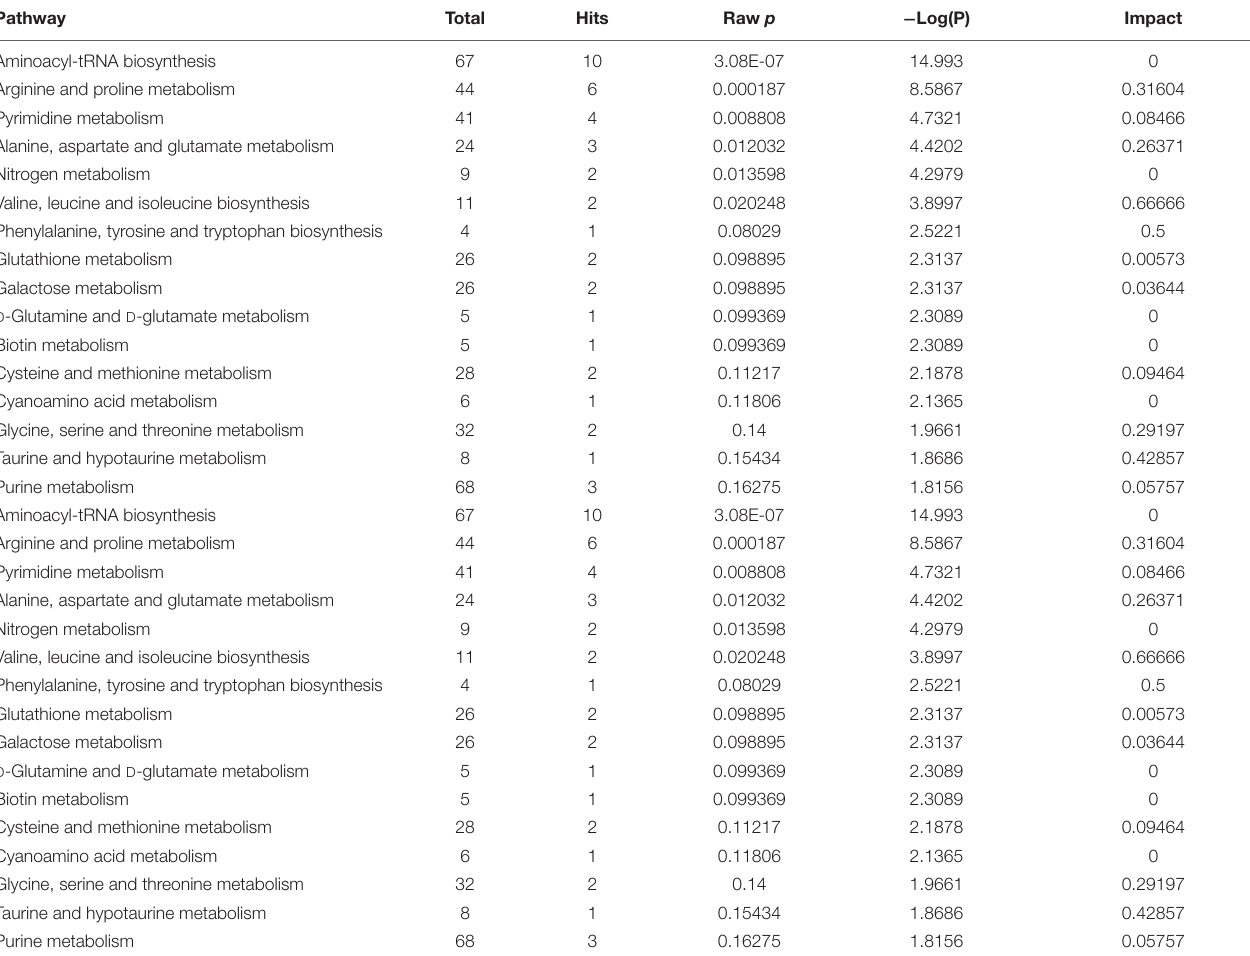
TABLE 1 | Detailed pathway analysis of significantly differentially expressed metabolites.